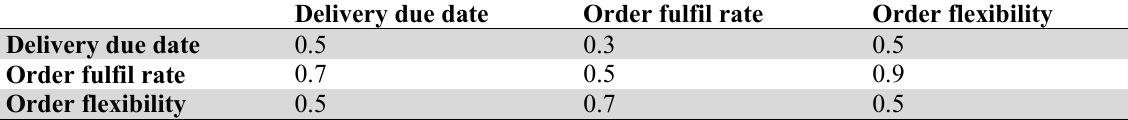
Non-Fuzzy pairwise comparison matrix of relative importance of sub-criteria of delivery